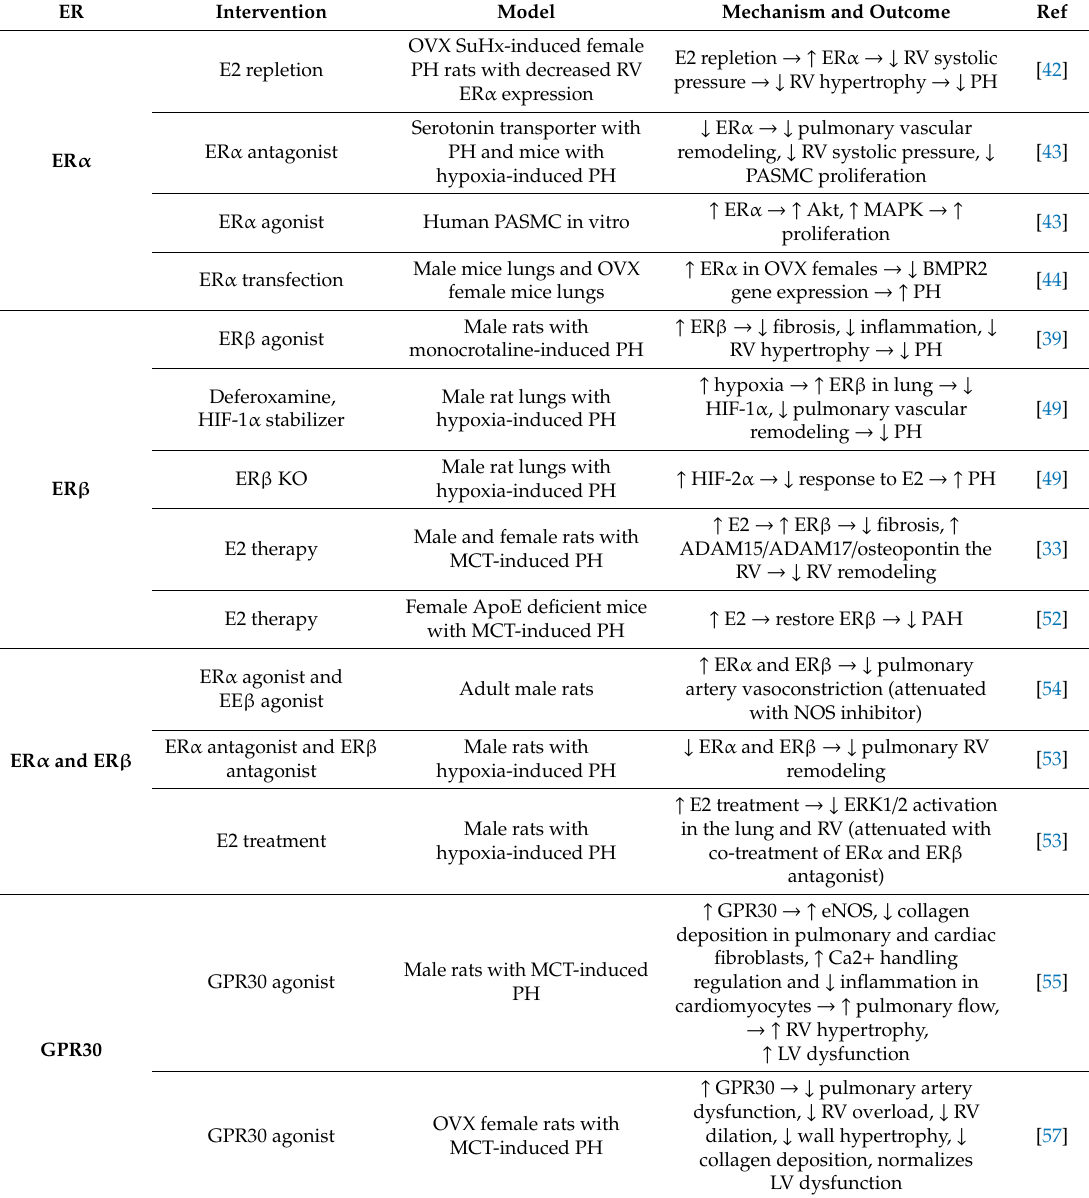
Table 2. Role of estrogen receptors in pulmonary